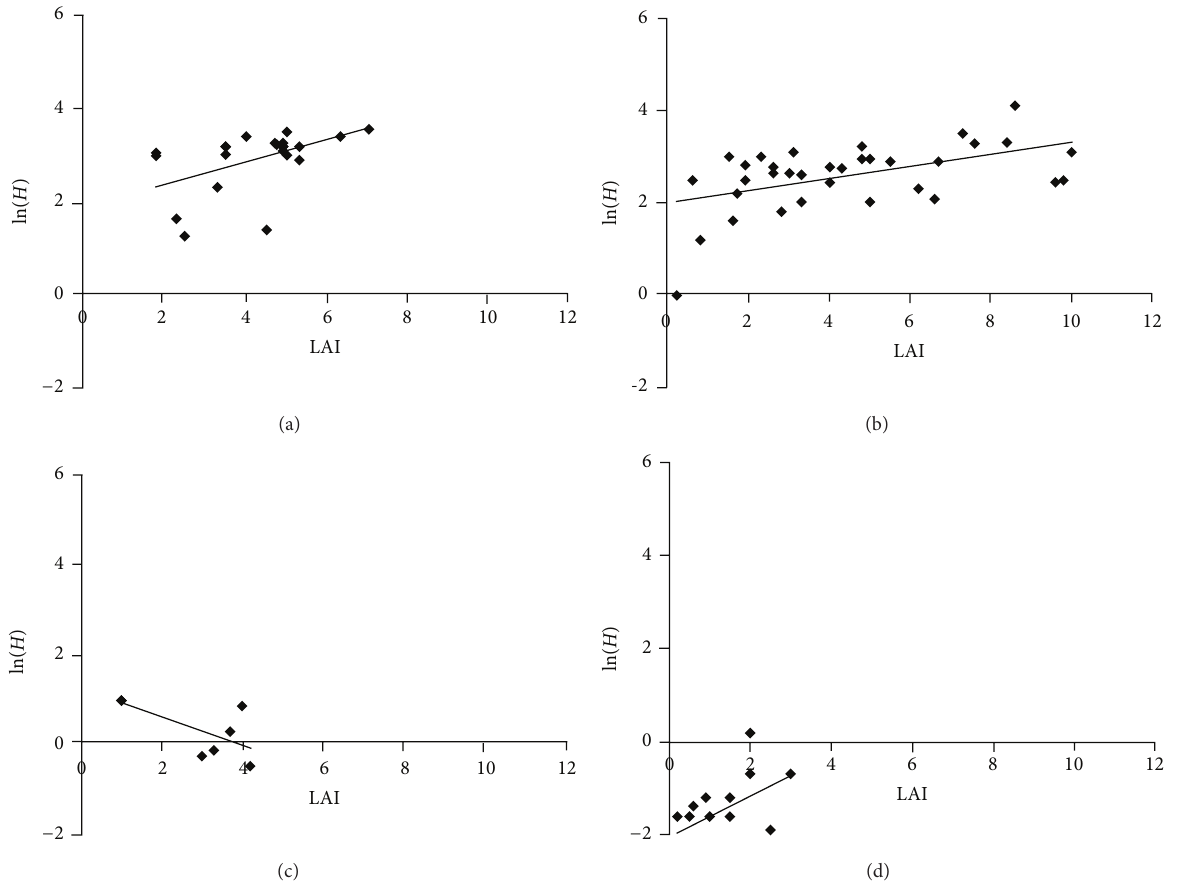
Figure 3: Scatter plots between ln( 𝐻 ) and LAI, (a) broadleaf forest, (b) needleleaf forest, (c) croplands, and (d) grasslands.